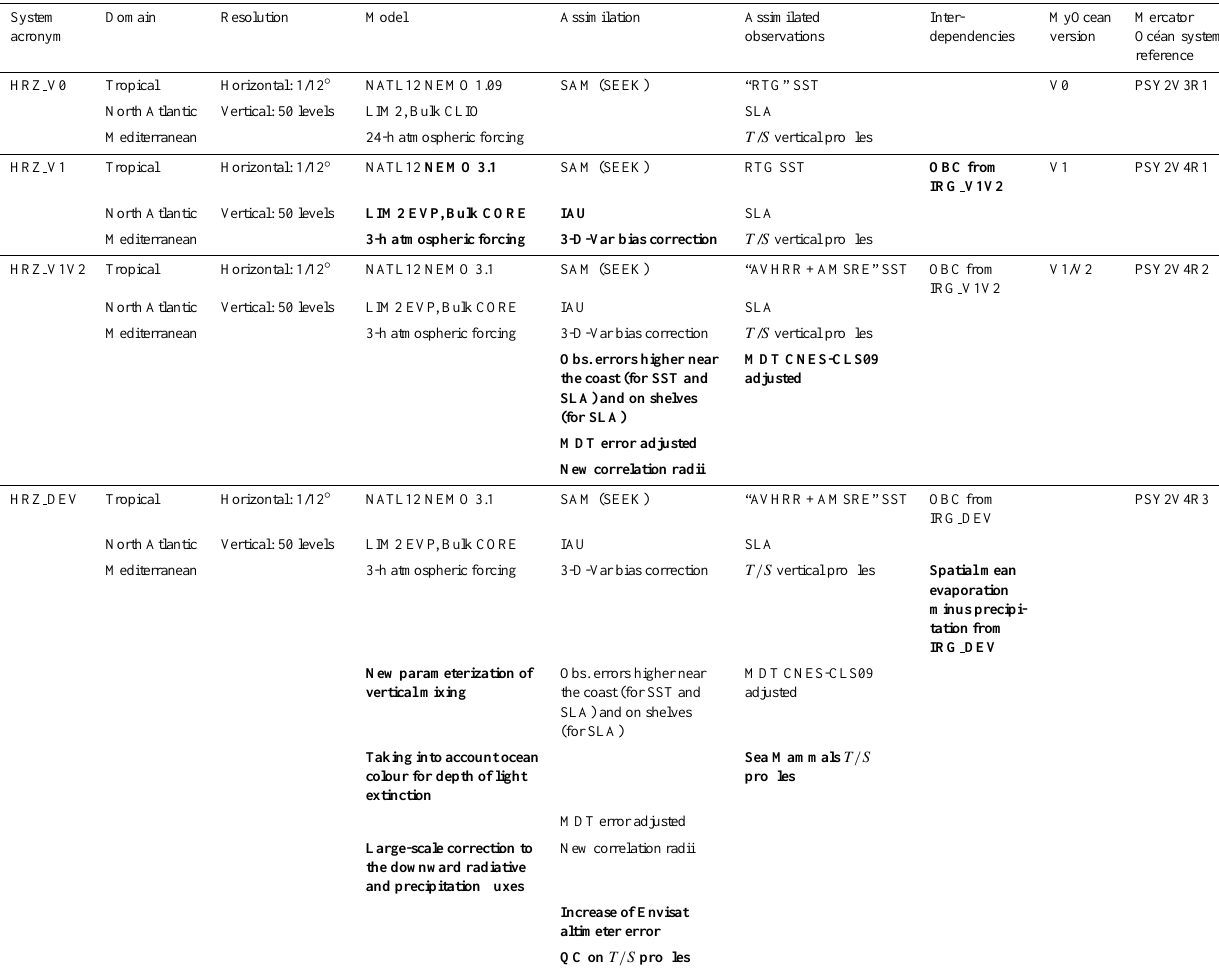
Table 2. Specifics of the Mercator Oc´ean HRZ systems. In bold, the major upgrades with respect to the previous version. System